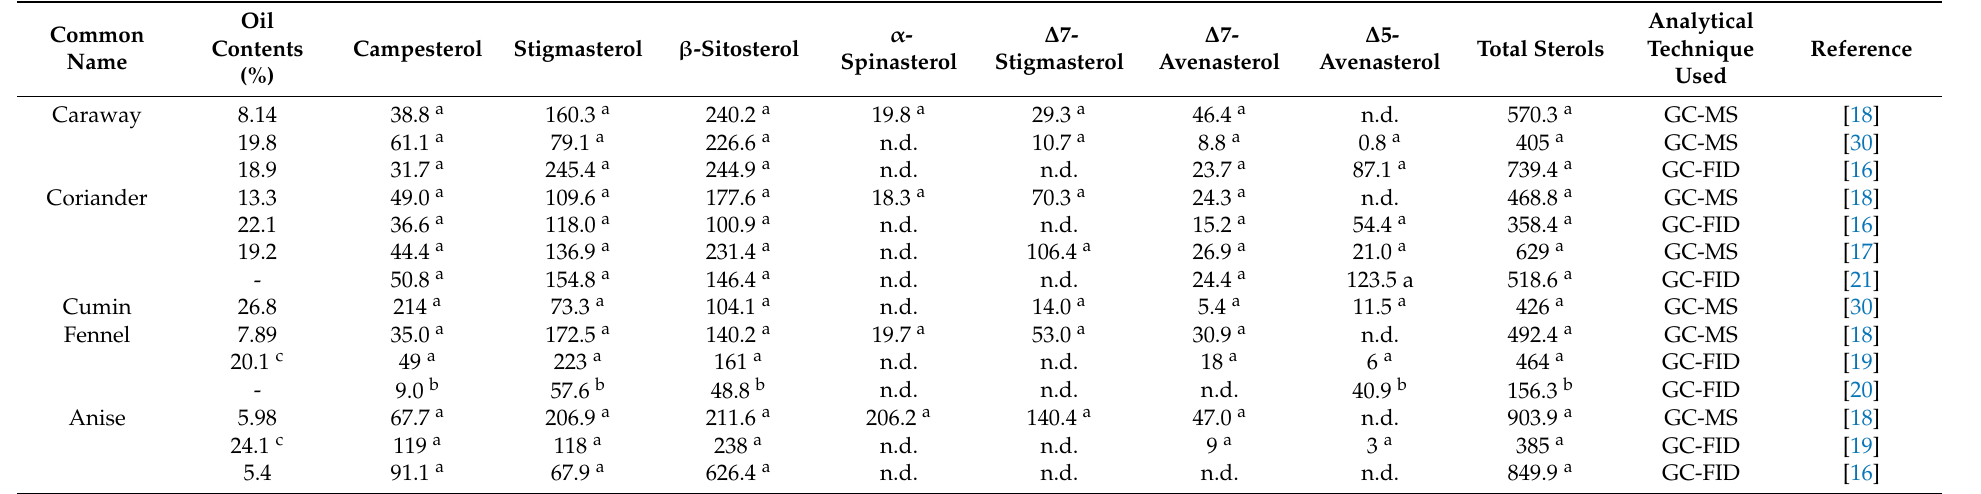
Table 2. Phytosterol composition of Apiaceae family seeds spices reported in previous